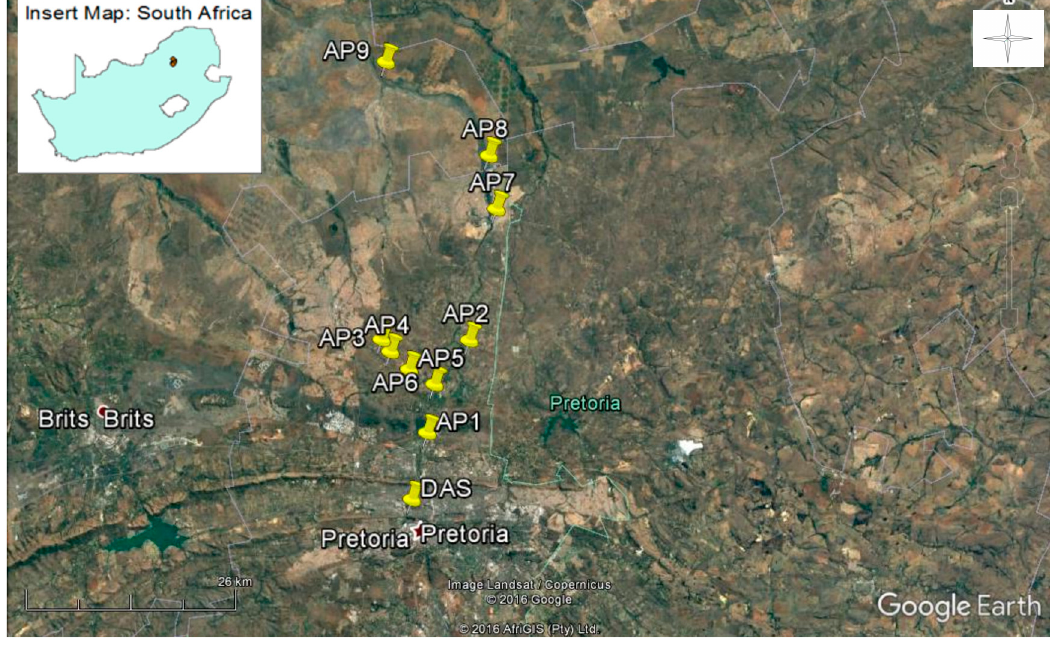
Figure 1. Map of study sites (Source: Google Earth). DAS: wastewater treatment plant; AP1–AP4, AP8: sites included in entrainment/resuspension parameters estimation; AP5, AP6, AP7: sediment and water collection sites for laboratory experiments; AP6 (raking site) and AP9 (cow-crossing site): field experiments.